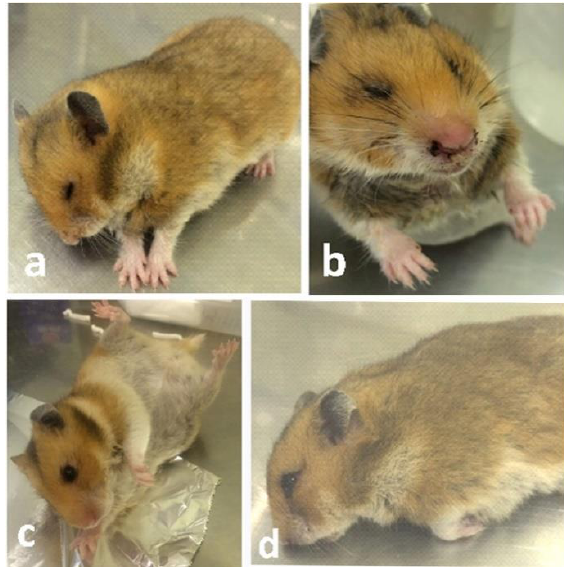
Figure 1. ( a ) Pregnant hamster inoculated with EHV-9 at the 1st trimester (5th day of gestation) suffered from head tilting and paddling at 3 dpi. ( b ) Pregnant hamster inoculated with EHV-9 at the 1st trimester (5th day of gestation) suffered bilateral nasal bleeding at full term (11th dpi). ( c ) Pregnant hamster inoculated with EHV-9 at the last trimester (10th day of gestation) exhibited convulsions at 6 dpi. ( d ) Pregnant hamster inoculated with EHV-9 at the last trimester (10th day of gestation) exhibited paralysis of hindquarter and recumbency at the 6th dpi.